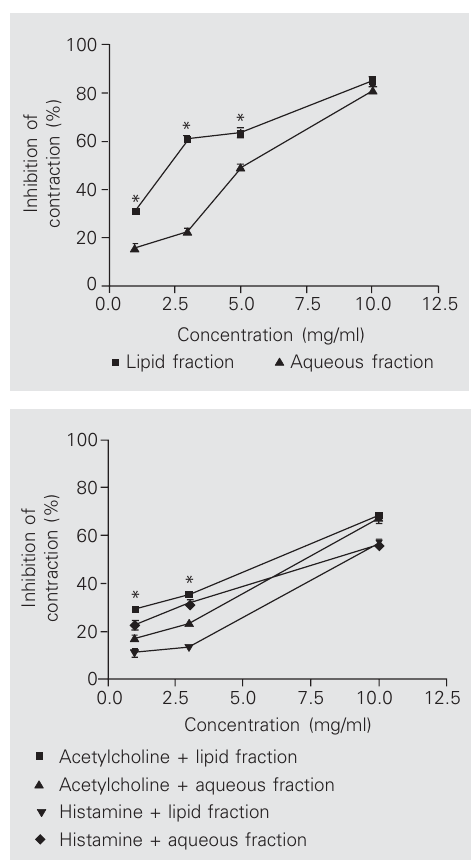
Data are reported as the means ± SEM for 10 rats. Lipid fractions 30, 100, 300 and 1000 mg/kg of both fractions and the positive control (dexamethasone) were signifi- cantly different (*P<0.05, Tukey test).